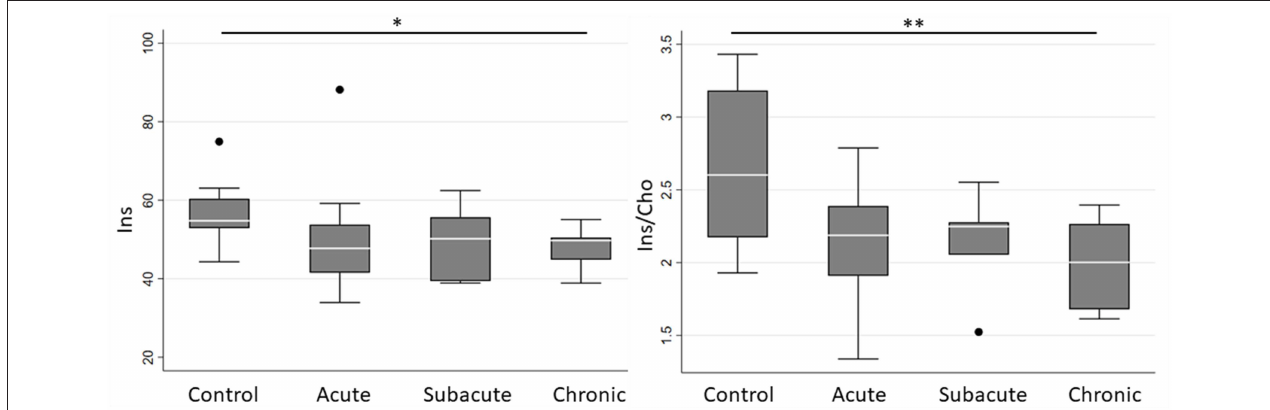
FIGURE 3 | Boxplot representations comparing median and interquartile range for total white matter Ins and Ins/Cho between controls and concussed patients at acute, subacute and chronic time points. Individual horizontal bars are presented for each significant group comparison. Ins = myo-inositol, Cho = choline compounds. * P < 0.1, ** p < 0.05 by Mann-Whitney